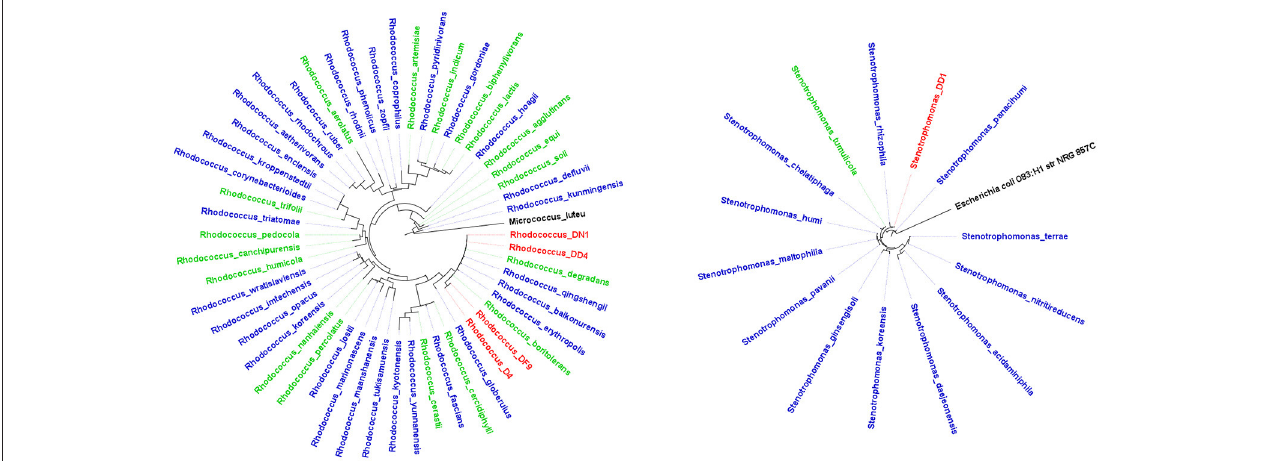
FIGURE 2 | Maximum-likelihood tree of some of the bacterial genera that exhibited the highest number of biotechnological features. (A) Rhodococcus and (B) Stenotrophomonas . Blue and green labels represent complete (available at NCBI) and incomplete (partial sequences available at NCBI) genomes, red labels represent isolates recovered in this study and black labels represent the